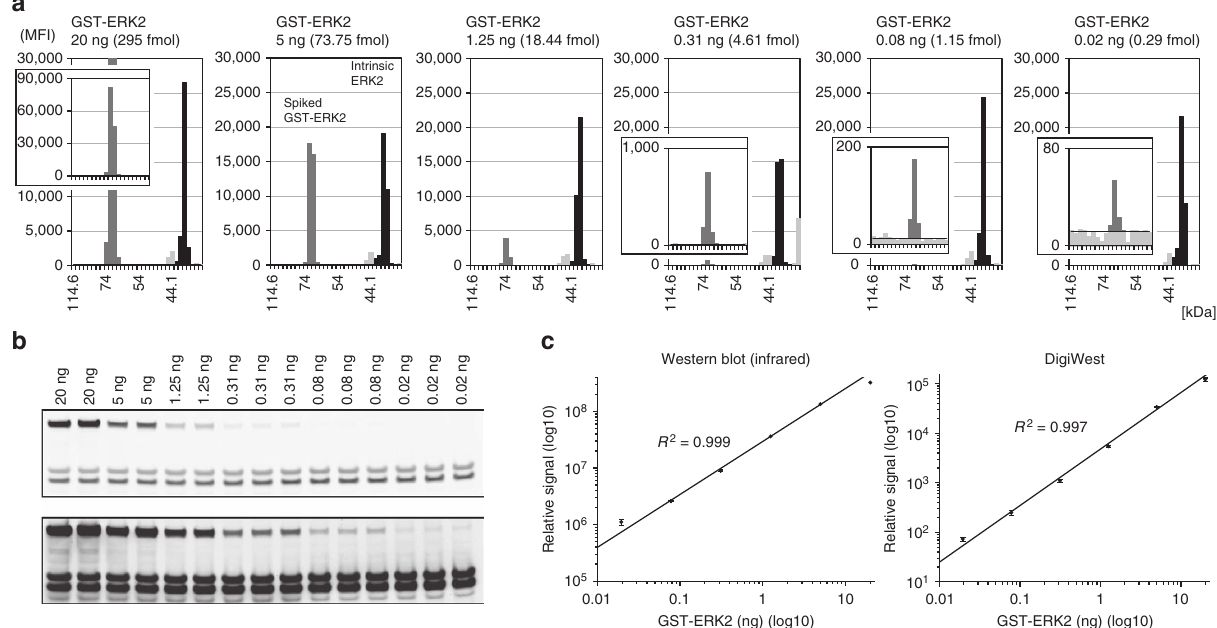
Figure 3 | Reproducibility, sensitivity and signal linearity. A total of 10 m g of HepG2 lysate per lane was spiked with a 1:4 dilution series of GST-ERK2, from 20ng to 20pg. ( a ) Three replicates for each spike amount were used to generate DigiWest bead pools. An ERK1/2-specific antibody was used. One replicate for each spike amount is represented as graphs (all 18 lanes containing 3 replicates for each spike amount and 4 repeated measurements are provided in Supplementary Fig. 2). Intrinsic ERK2 is shown in dark grey, spiked GST-ERK2 in medium grey and intrinsic ERK1 in light grey. ( b ) The same samples on a western blot detected on a Li-COR Odyssey using the same primary antibody. The image is shown at two illuminations levels to depict the full GST-ERK2 dilution series. The three highest concentrations are only shown in duplicate because of the limited number of lanes on the gel. ( c ) Relative signal obtained from western blot (no error bars for the three highest concentrations) and DigiWest. Both axes are log10